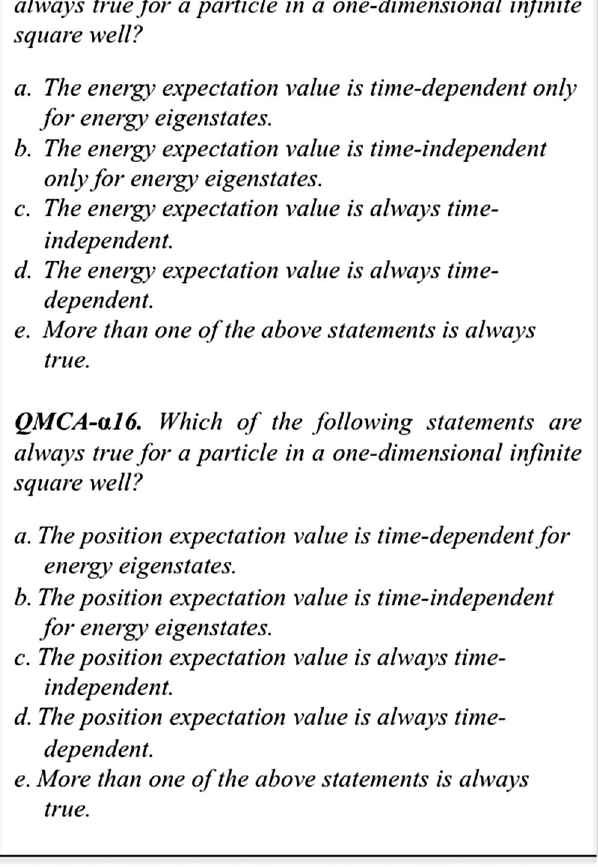
FIG. 6. Additional questions on time evolution of energy and position expectation values in the QMCA alpha version.